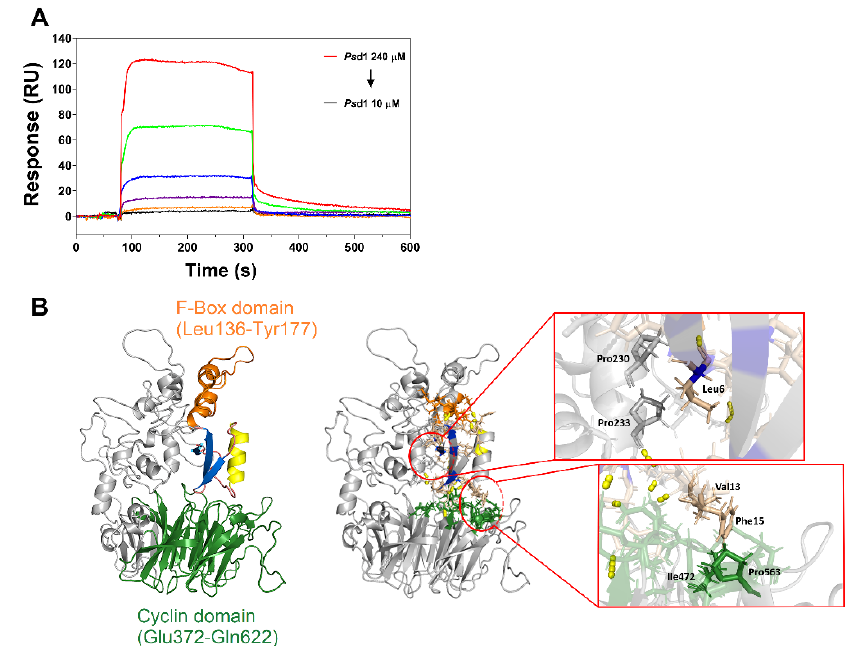
Figure 5. ( A ) The Ps d1-cyclin F interaction was confirmed by surface Plasmon resonance SPR. Sensorgram curves demonstrating the association and dissociation phases of immobilized cyclin F on the CM5 chip surface with di ff erent concentrations of Ps d1: 10 µ M (black), 20 µ M (orange), 40 µ M (purple), 80 µ M (blue), 160 µ M (green) and 240 µ M (red). Each experimental condition was performed at least twice. ( B ) The most favorable pose for the Ps d1-cyclin F interaction predicted by molecular modeling simulations. Left cartoon: Human cyclin F domains were designated in orange for the F-box domain and green for the cyclin domain (also known as the WD domain); Ps d1 secondary structures are shown in blue for β -strands and yellow for α -helices attached by pale pink loops(Protein Database Bank (PDB accession number 1JKZ). Right cartoon: Amino acid residues involved in the hydrophobic interface clusters are highlighted by red balloons and shown in the inset zoom images (Leu 6 from Ps d1 with Pro 230 and Pro 233 belonging to F-box domain of cyclin F, and Val 13 and Phe 15 from Psd1 with Ile 472 and Pro 563 belonging to the cyclin domain of cyclin F).